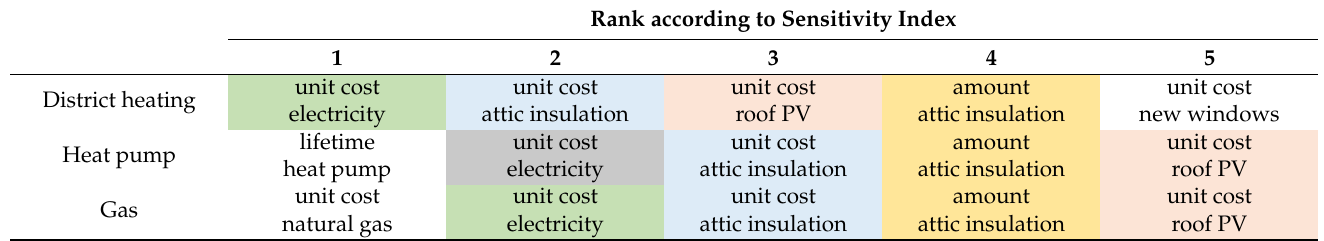
Table 2. First five most sensitive parameters for each system, excluding the energy required for build- ing operation. Background color identifies identical input parameters for each energy supply